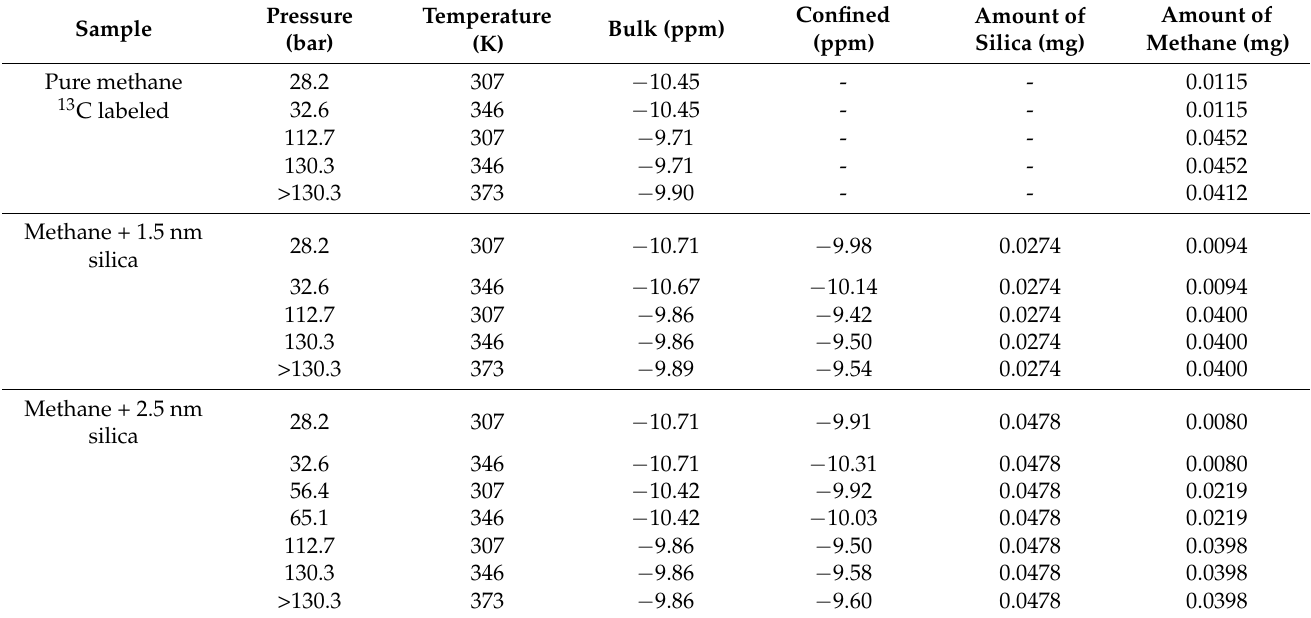
Table 2. Sample conditions, compositions, and measured 13 C NMR isotropic chemical shift values of methane in the pure state and mixtures with silica